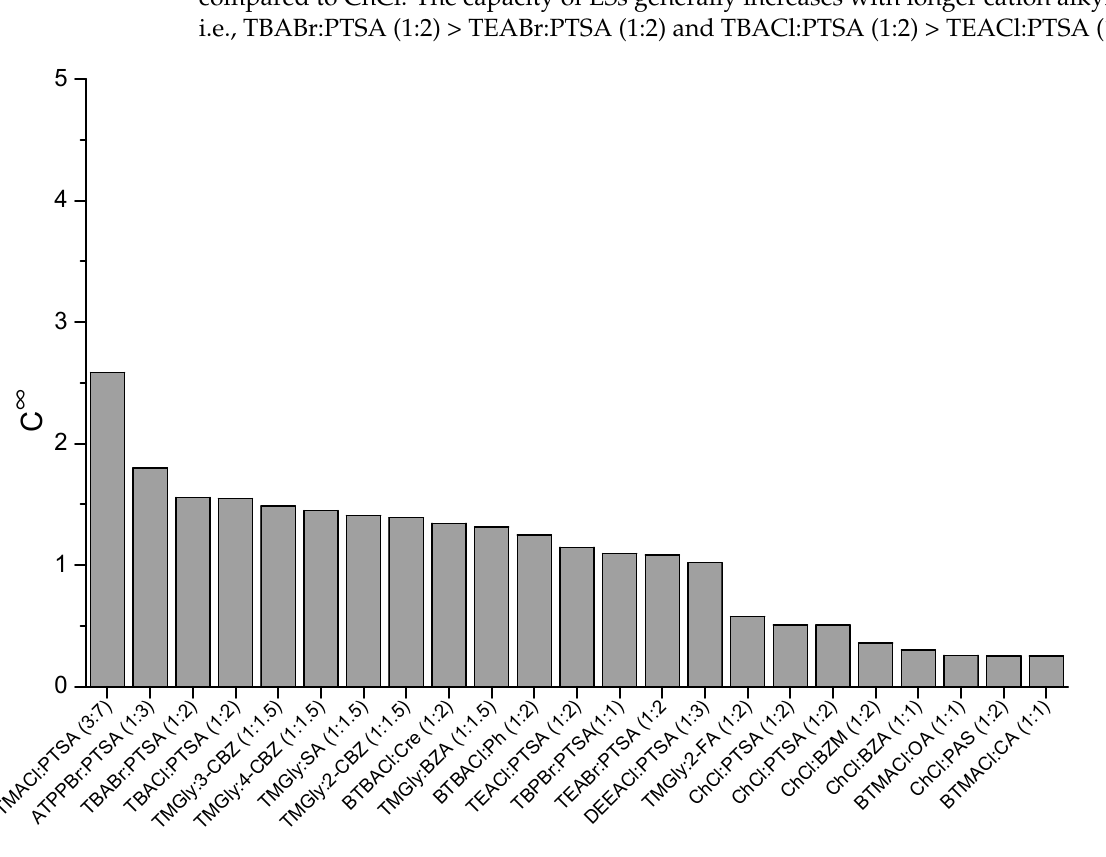
Figure 1. Capacity of ESs at infinite dilution.